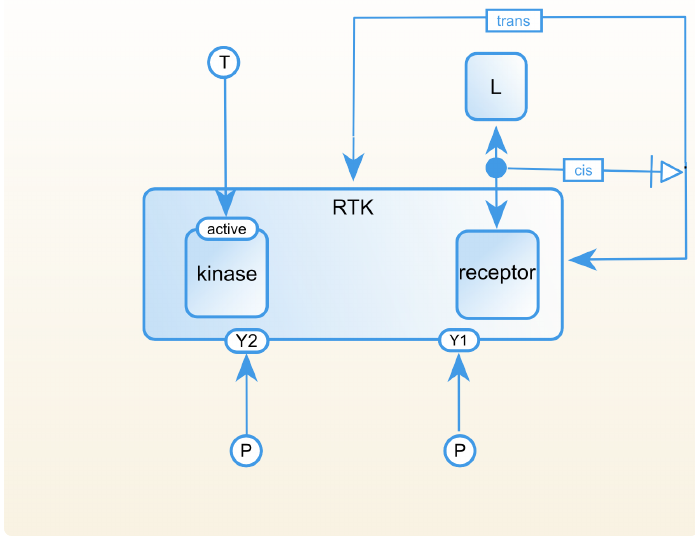
Figure A.5: Receptor tyrosine kinase activation: control of the dimer formation.